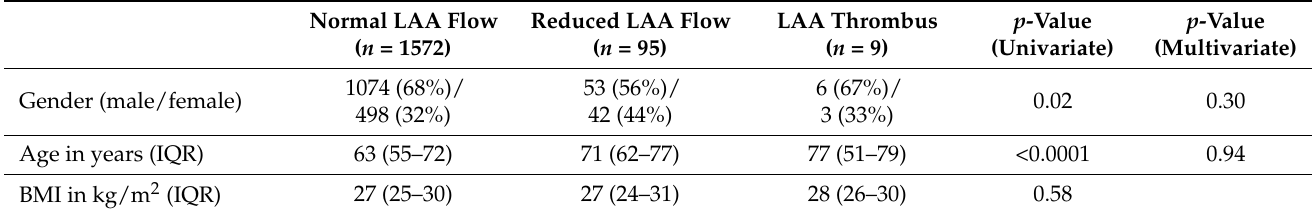
Table 2. Comparison between patients with normal LAA flow, patients with significantly reduced flow and patients with a LAA